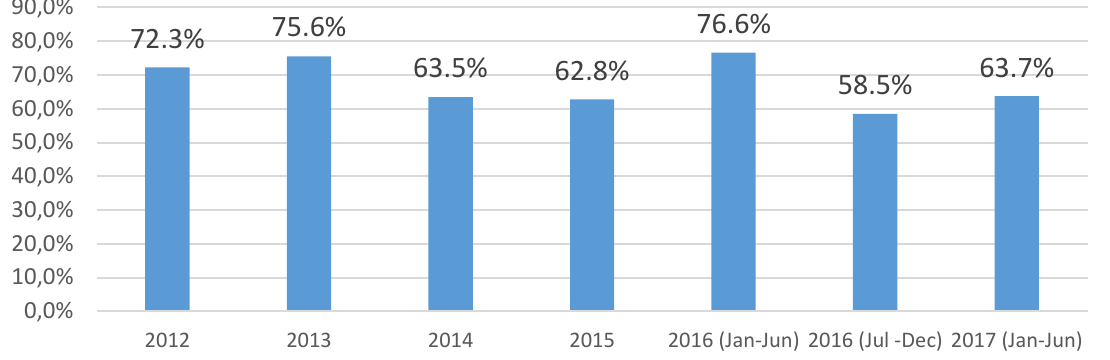
Figure 2. Dynamics of the indicator of the efficiency of open bidding in Ukraine,